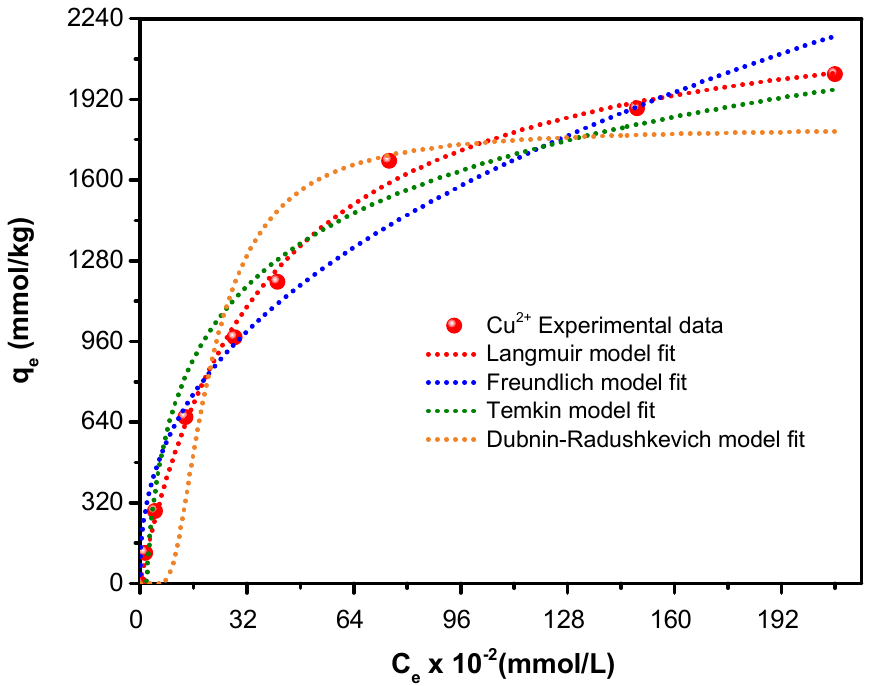
Figure 4. The nonlinear illustration of the equilibrium experimental data.